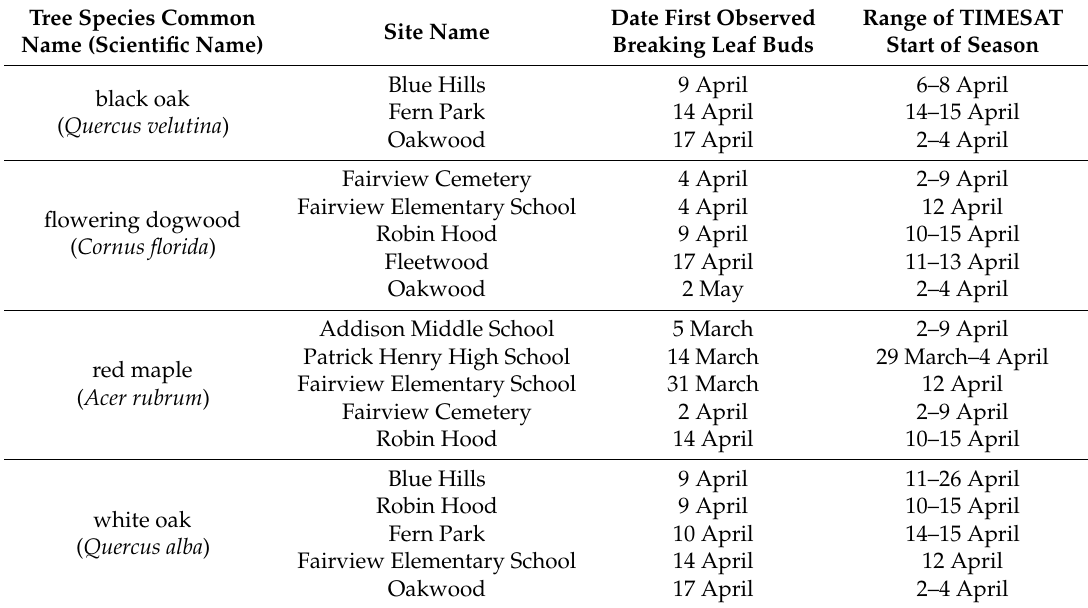
Table 3. 2014 in-situ phenology monitoring results compared with